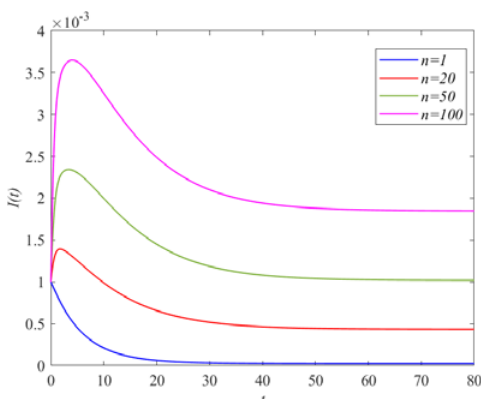
Fig. 3. Spread behavior of the model.